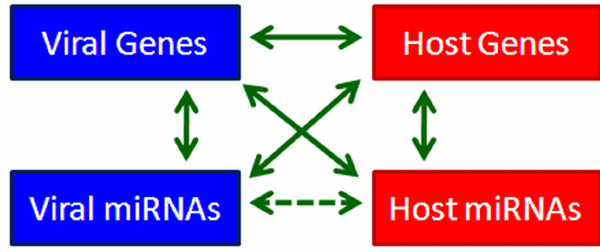
number of studies, we infer that KSHV hijacks the host miRNA system to favor infection and